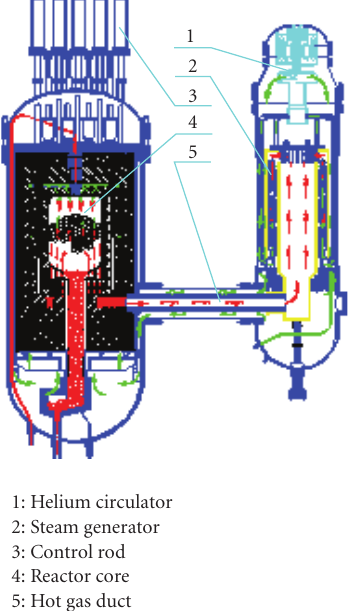
Figure 1: The side-by-side arrangement of pressure vessels for HTR-10. (1) Helium circulator, (2) steam generator, (3) control rod, (4) reactor core, and (5) hot gas